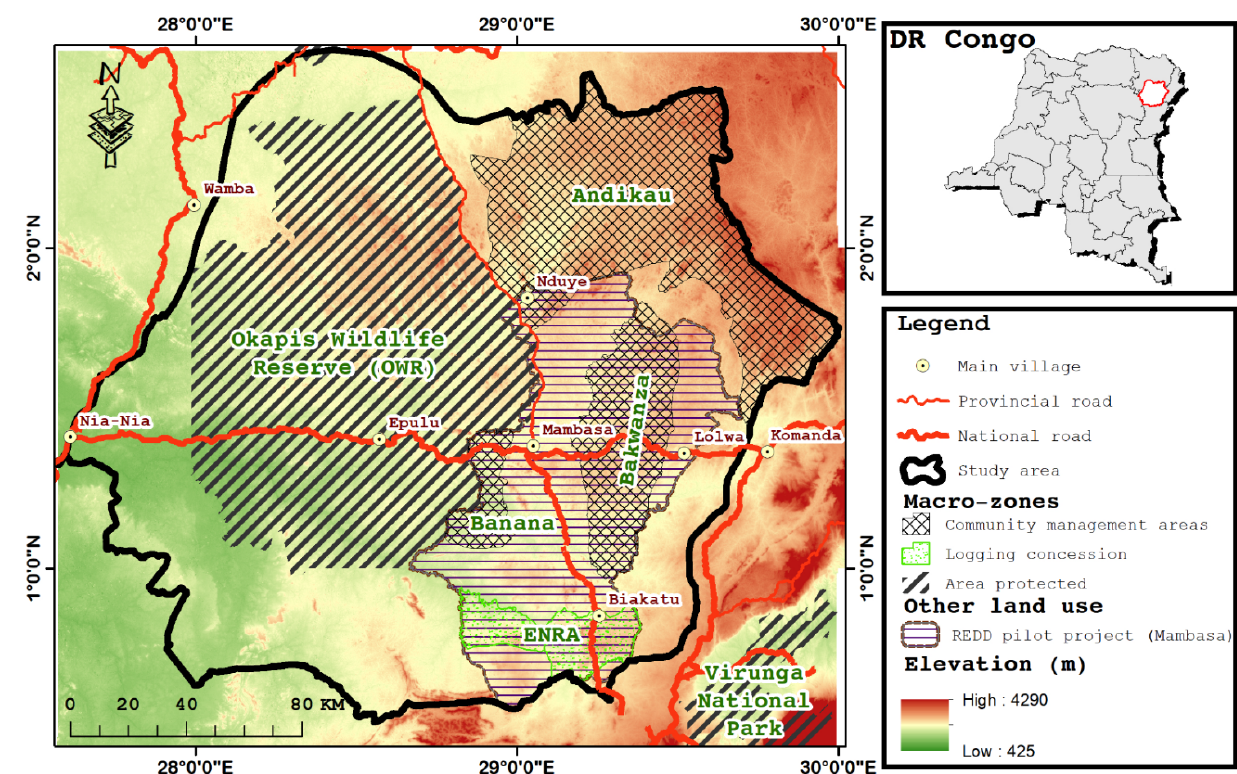
Figure 1. Geographical and topographical context of the study area.